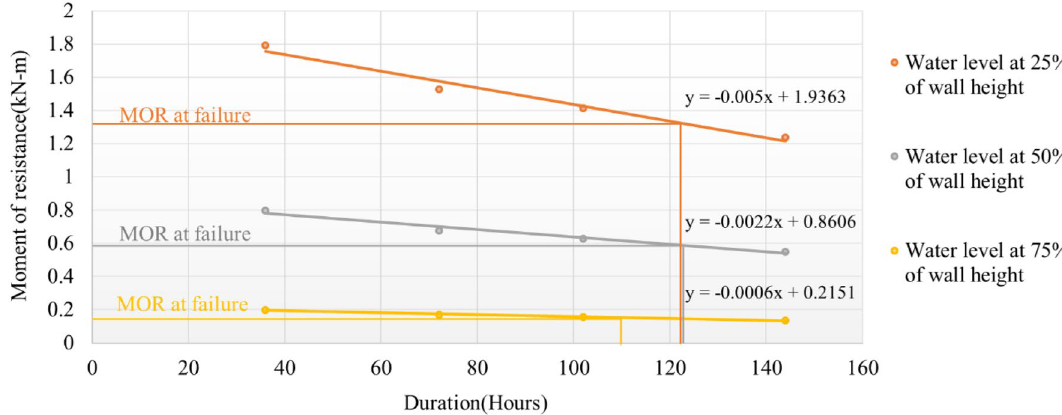
Figure 8. Failure duration corresponding to MOR.